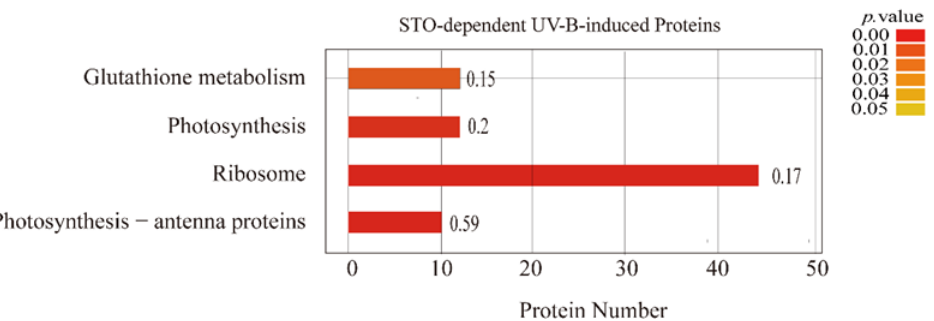
Figure 5. KEGG enrichment analysis of STO-dependent UV-B-induced proteins. The color gradient indicates the P value. The smaller P value indicates that the color is closer to red, the higher the level of pathway enrichment. The number on the bar graph indicates the rich factor (rich factor <= 1), referring to the percentage of di ff erential proteins that are involved in this pathway.